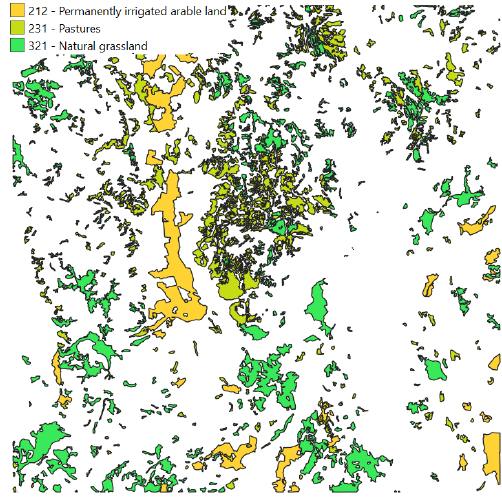
Figure 3. North Macedonia: distribution of LC classes.